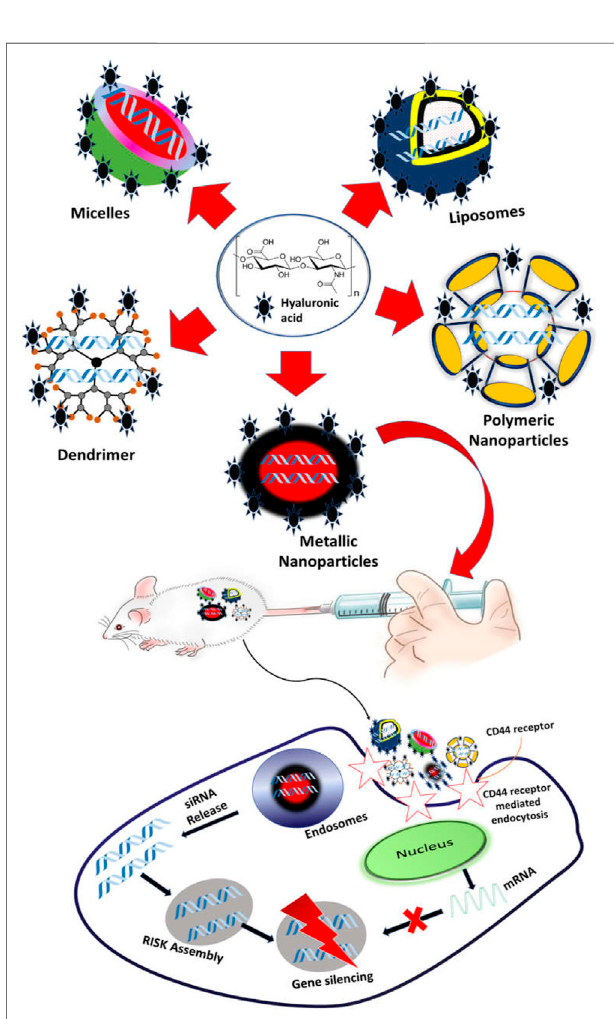
FIGURE 8 | CD44-mediated siRNA